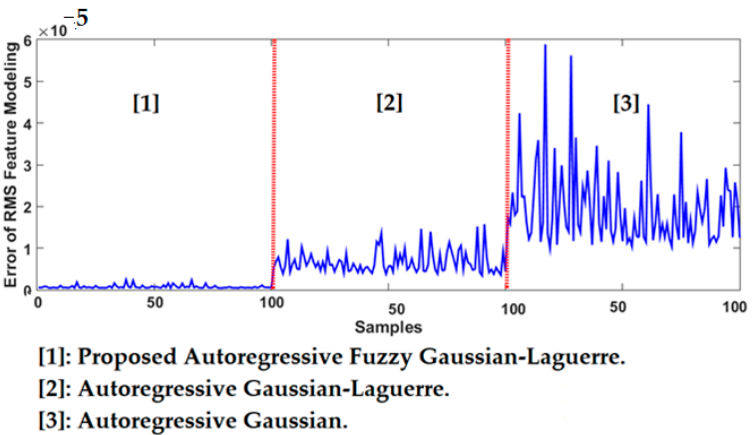
Figure 7. The error of RMS signal modeling using the proposed autoregressive fuzzy Gauss–La- guerre algorithm, autoregressive Gauss–Laguerre technique, and autoregressive Gaussian method for normal conditions.